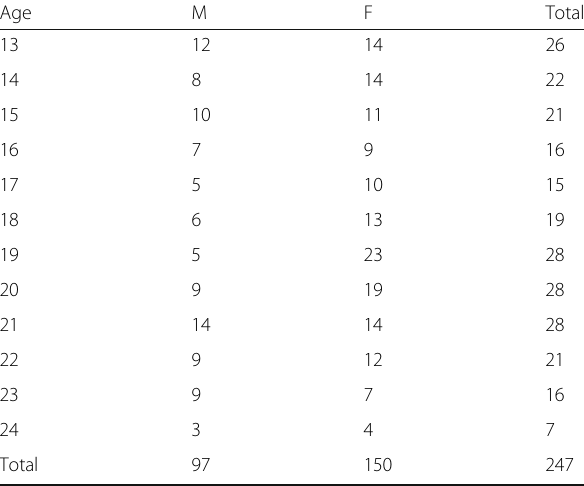
Table 1 Sample of panoramic radiographs from Egyptian individuals according to sex and age categories